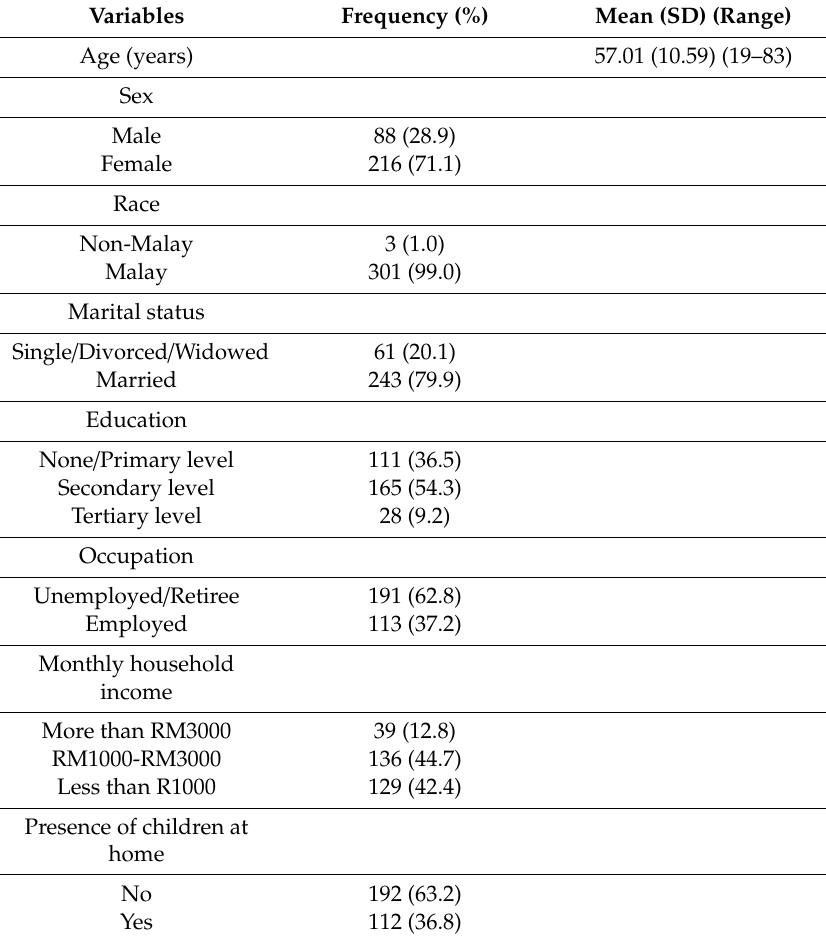
Table 1. Socio-demographic characteristics of Type 2 diabetic patients on insulin ( n =